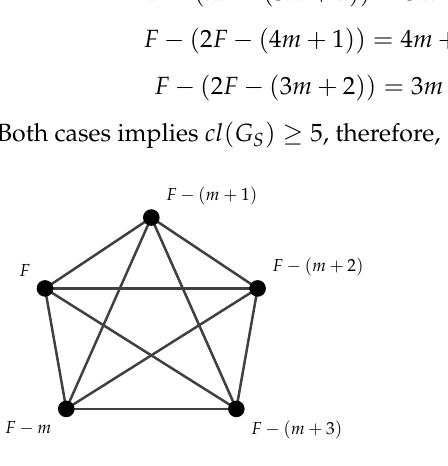
Figure 7. Minimum possible clique for the case m ≥ 2 q + 4, e = m − 2 q − 1 and q =